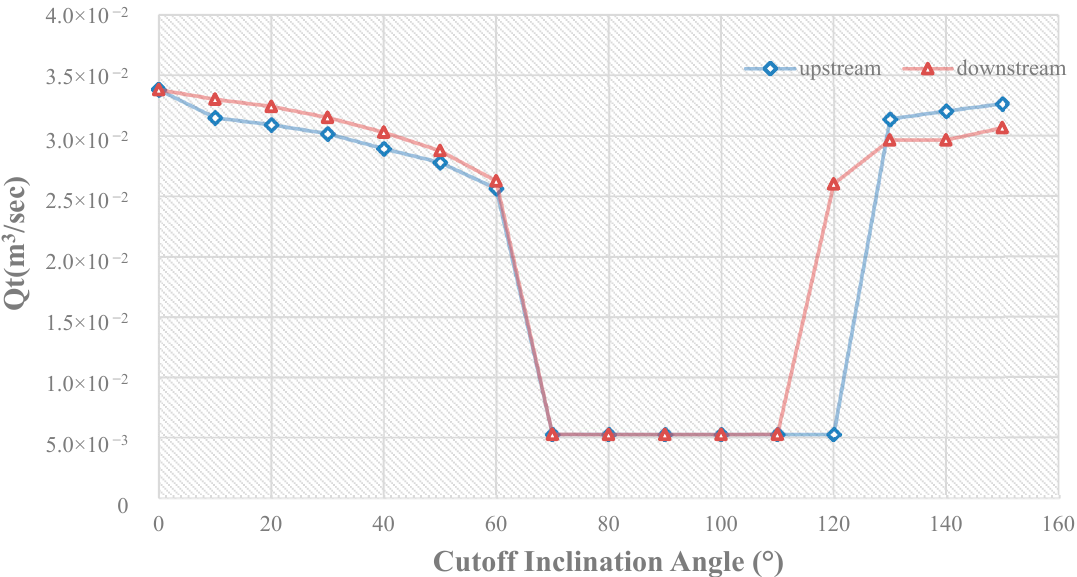
Figure 9. Seepage discharge of the cross section of the dam in different angles.